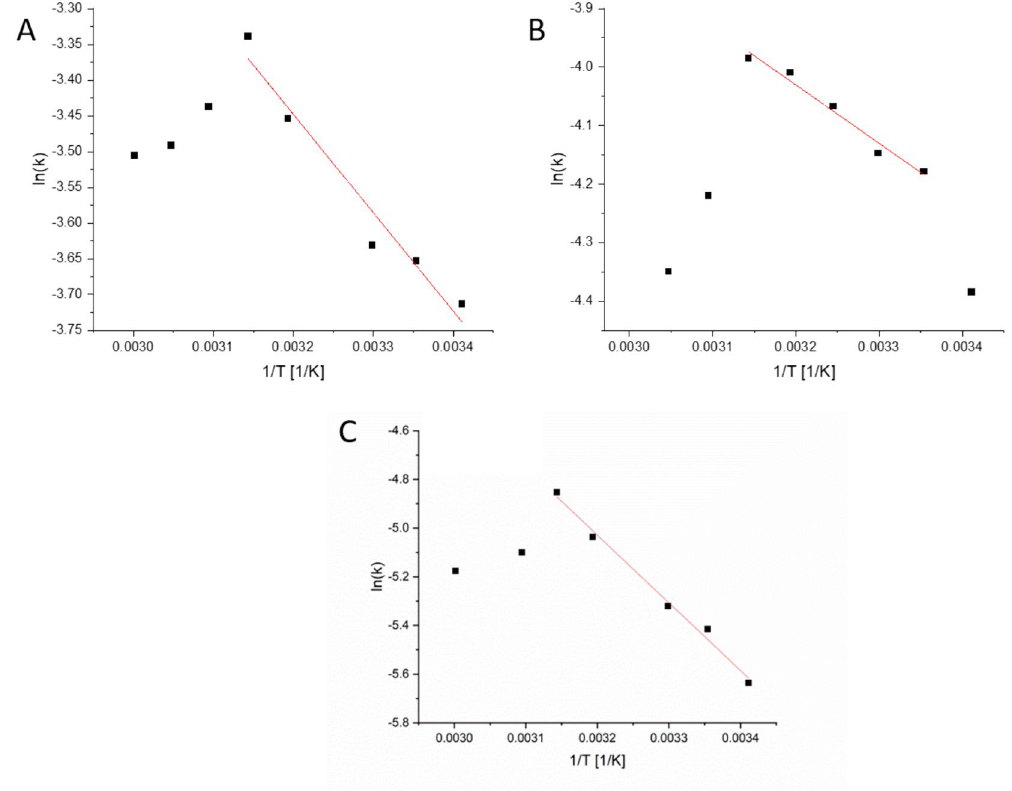
Figure 5. Arrhenius activation energy analysis of ( A ) free l-asparaginase towards l-asparagine, ( B ) l-asparaginase@Au towards l-asparagine, and ( C ) l-asparaginase@Au towards d-asparagine.